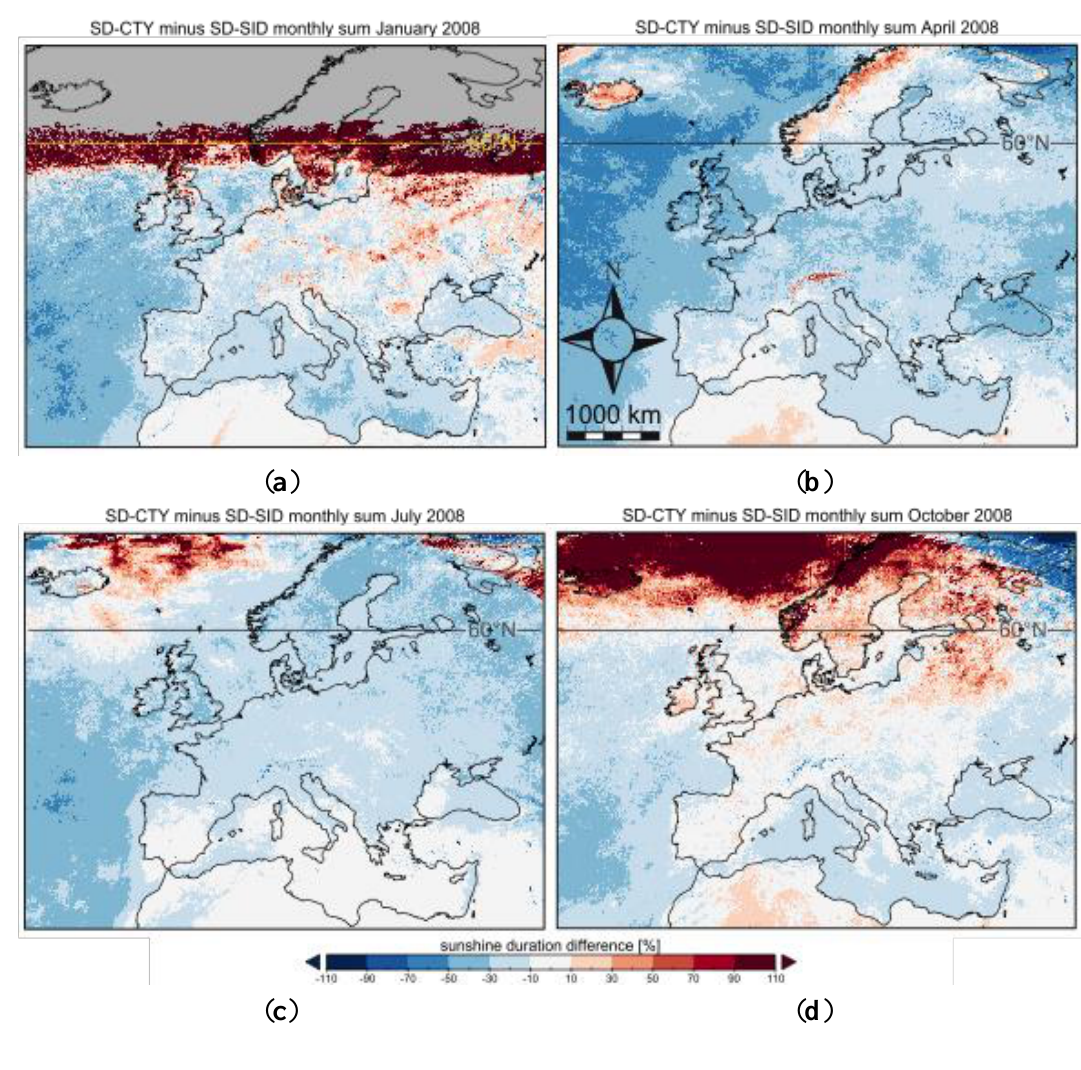
Figure 4. SD-CTY minus SD-SID differences for January ( a ), April ( b ), July ( c ), and October ( d ) for the year 2008. The panels show relative differences (in percent) in reference to